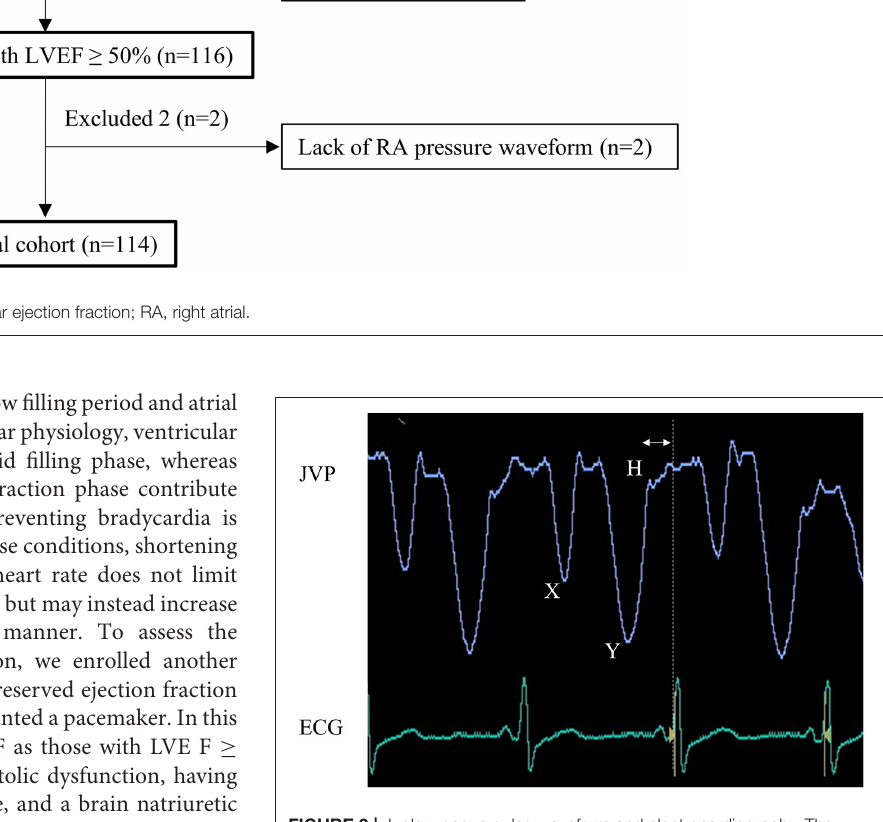
FIGURE 2 | Juglar venous pulse waveform and electrocardiography. The jugular venous pulse waveform was recorded from an 87-year-old woman with heart failure with preserved ejection fraction and sinus arrest. This waveform shows a dominant “Y” descent deeper than that of “X” and is accompanied by an “H” wave, highly indicative of decreased right ventricular distensibility. To determine optimal heart rate, we shortened the diastolic period by the time between the end of the Y descent and the next R wave on electrocardiography (double-headed